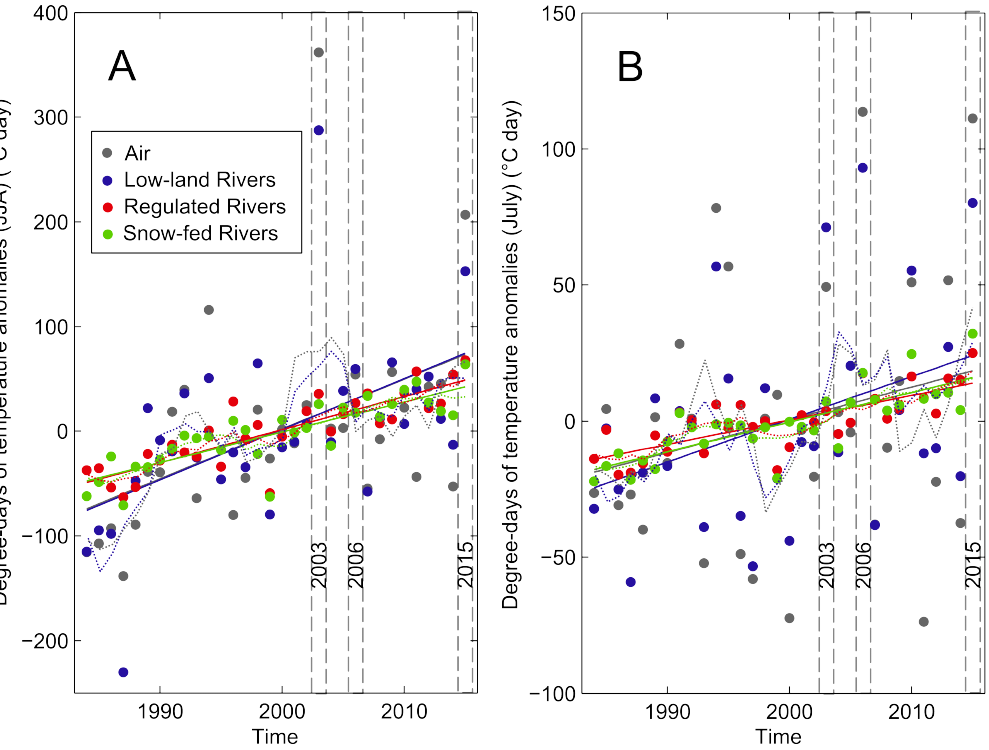
Figure 6. Cumulative degree-days of average temperature anomalies (dots) in JJA ( A ) and July ( B ). The long-term linear trends (continuous lines, see Table 3 for significance values) and the five-year moving average lines (dotted lines) are also plotted. Table 3. Results from linear regression (slope m , coefficient of determination R 2 , and significance level p of the F test) used to evaluate long-term trends of DD for the period JJA and for July. Linear regression is considered statistically significant for p -value <